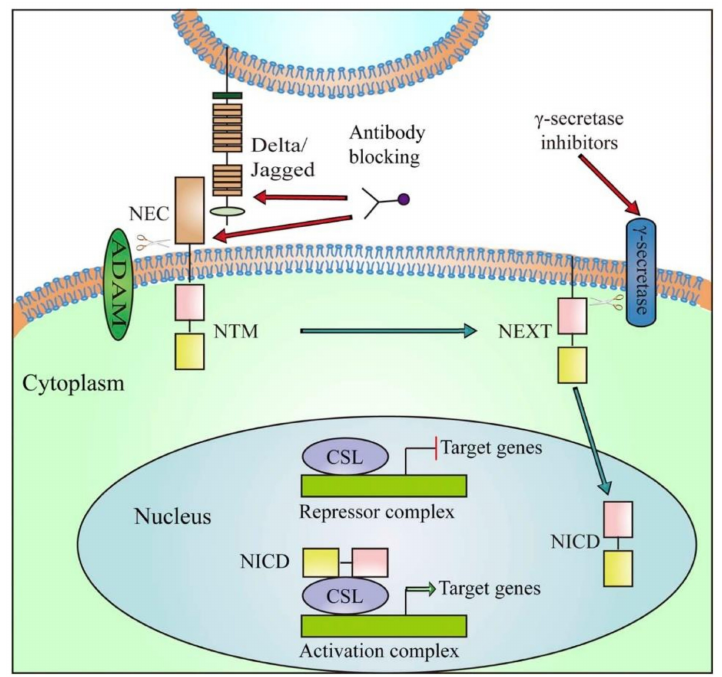
Figure 1. Diagram of Notch receptor activation and therapeutic target in clinical development. Notch signaling is initiated by ligand binding to Notch receptor, which undergoes a two-step proteolytic cleavage by ADAM family proteases and γ -secretase, releasing the Notch intracellular domain (NICD). The NICD translocates to the nucleus where it binds to CSL and converts the complex from a repressor to an activator of Notch target genes. Notch signaling could be inhibited by two major classes of Notch inhibitors: γ -secretase inhibitors and monoclonal antibodies directing against Notch receptors or ligands. Abbreviations: NEC, Notch extracellular subunit; NTM, Notch transmembrane fragment; NEXT, Notch extracellular truncated; CSL, C protein binding factor 1 / Suppressor of Hairless / Lag-1; NICD, Notch Intracellular Domain. Reproduced with permission from Yuan X, Wu H, Xu H, Xiong H, Chu Q, Yu S. Notch signaling: An emerging therapeutic target for cancer treatment. Cancer